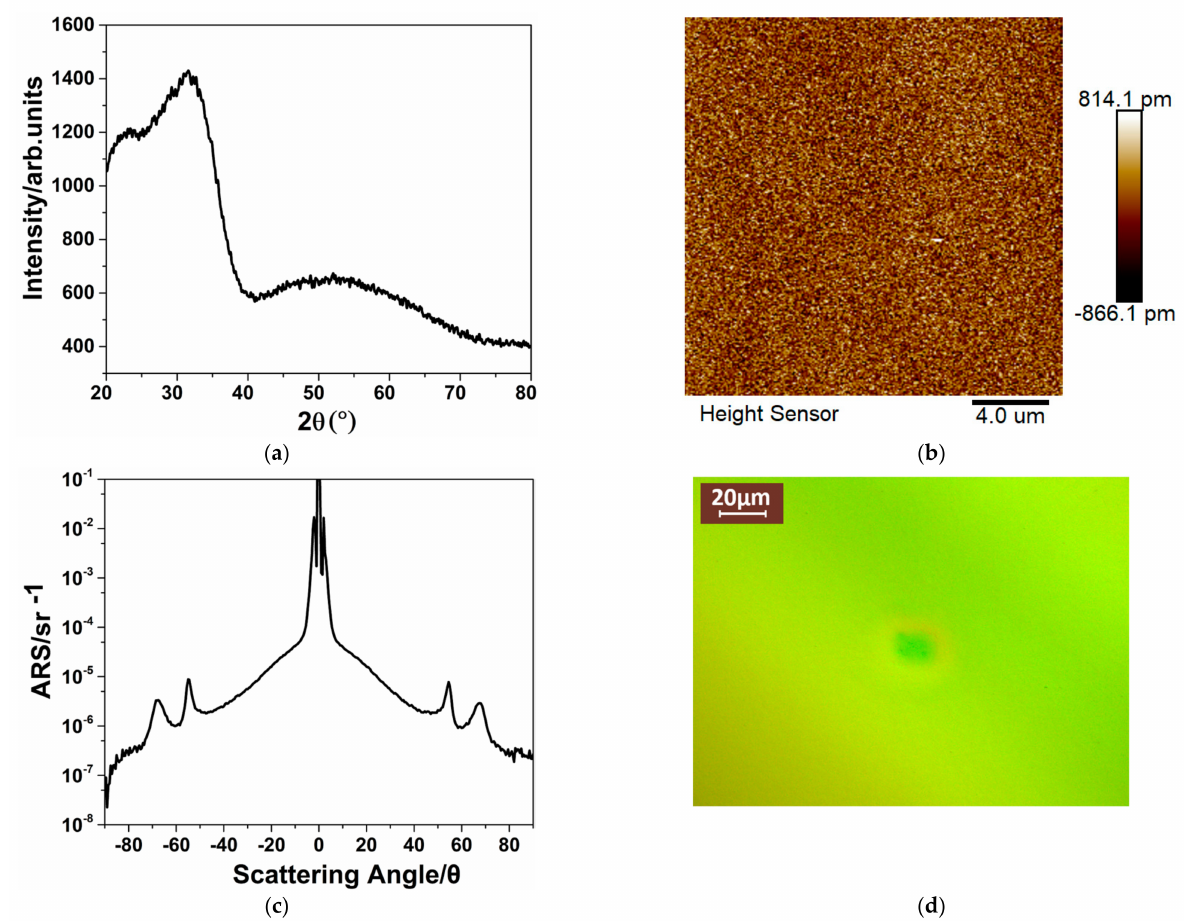
Figure 9. X-ray diffraction (XRD) spectra ( a ), atomic force microscopy (AFM) map ( b ), ARS ( c ), and typical damage morphology ( d ) of the 1064-nm high reflective coatings consisting of SiO 2 and Hf 0.70 Si 0.30 O 2 after 600 ◦ C